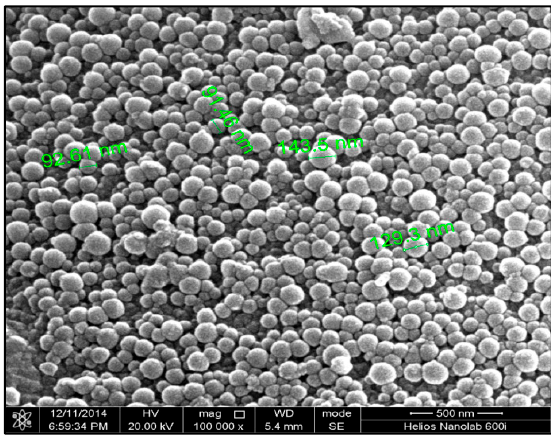
Figure 2. SEM picture of PPM.